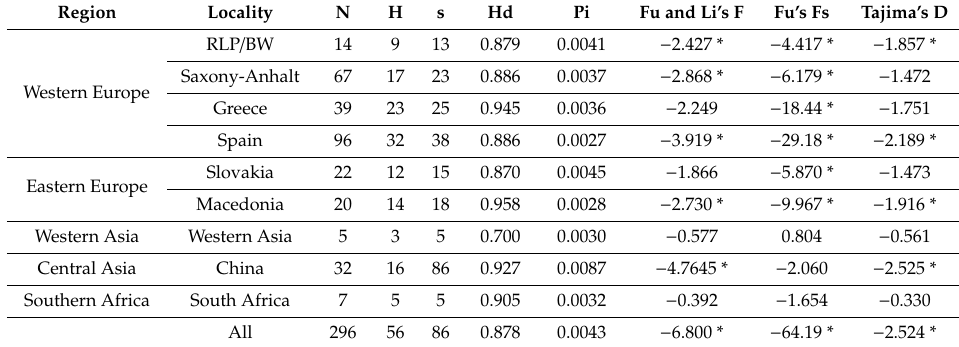
Figure 2. Mismatch distribution of frequencies of the pairwise number of differences among Merops apiaster populations. The dotted line represents the observed values in a stable population with a constant population size. The solid line represents the observed frequency of the pairwise mismatch distribution of mtDNA.